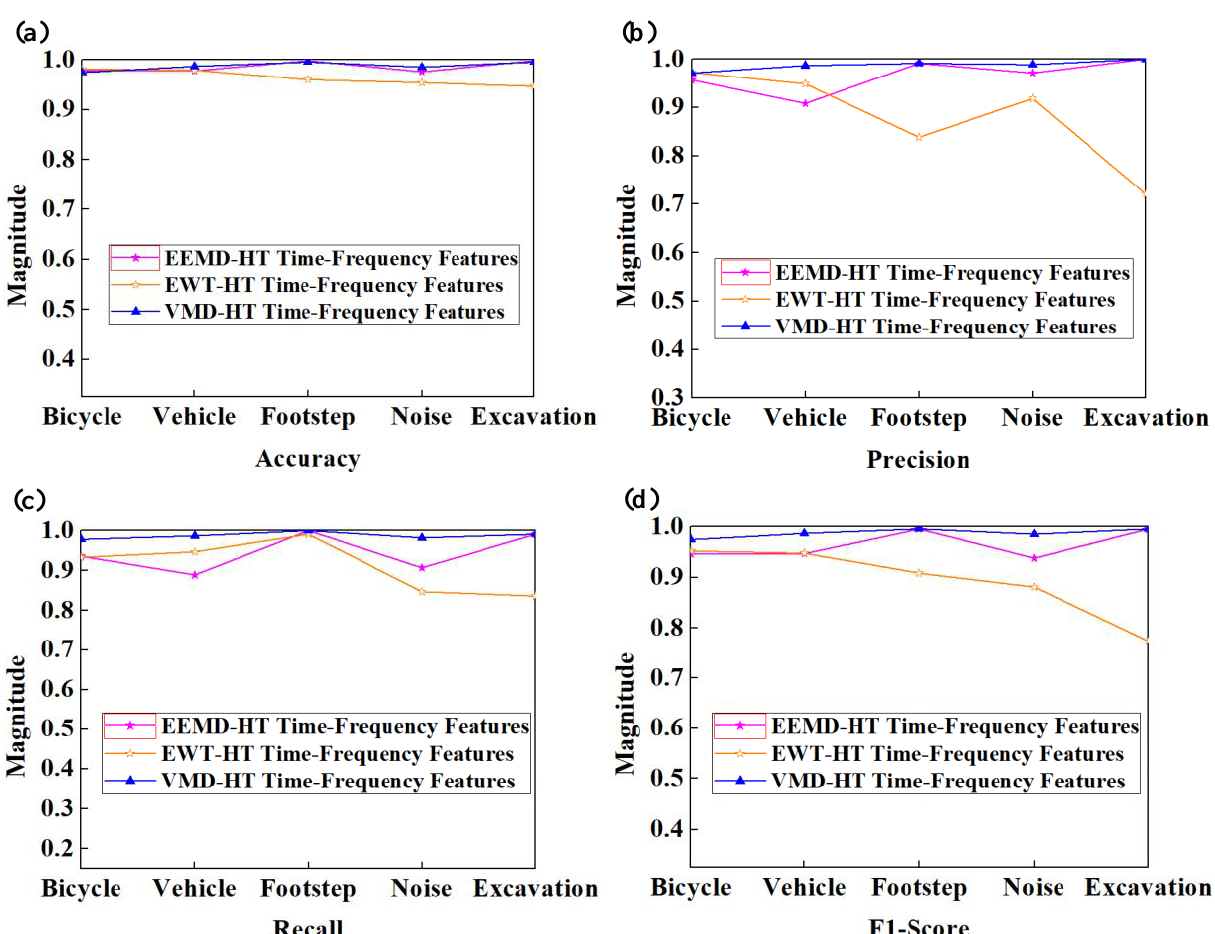
Figure 8. The confusion matrices obtained from testing sets generated by different time-frequency methods. ( a ) Ensemble empirical mode decomposition and Hilbert transform (EEMD-HT) time-fre- quency features. ( b ) Empirical wavelet transform and Hilbert transform (EWT-HT) time-frequency features.